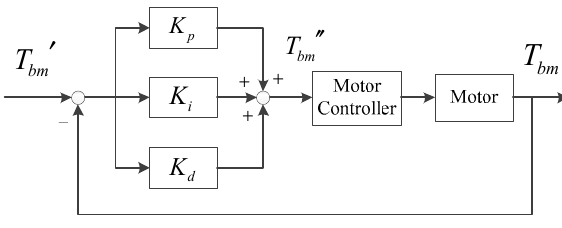
Figure 10. Motor torque PID control algorithm.